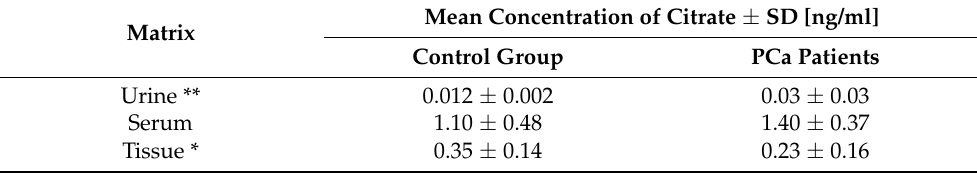
Table 1. The average concentration of citric acid arranged regarding three studied matrices. The table shows non-adjusted p -values referring to a comparison between the concentration of parameters in the control and positive groups. * = concentration in the extract, normalized by weight; ** = concentration normalized to creatinine; SD = standard deviation.